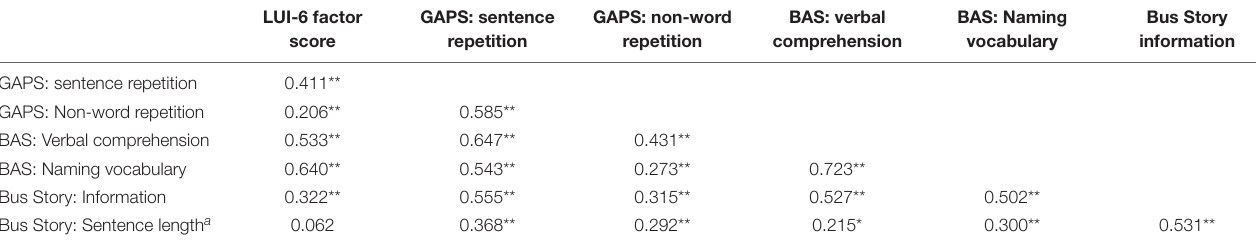
TABLE 4 | Zero order correlations between LUI-6 factor score and directly assessed language skills ( n = 312).